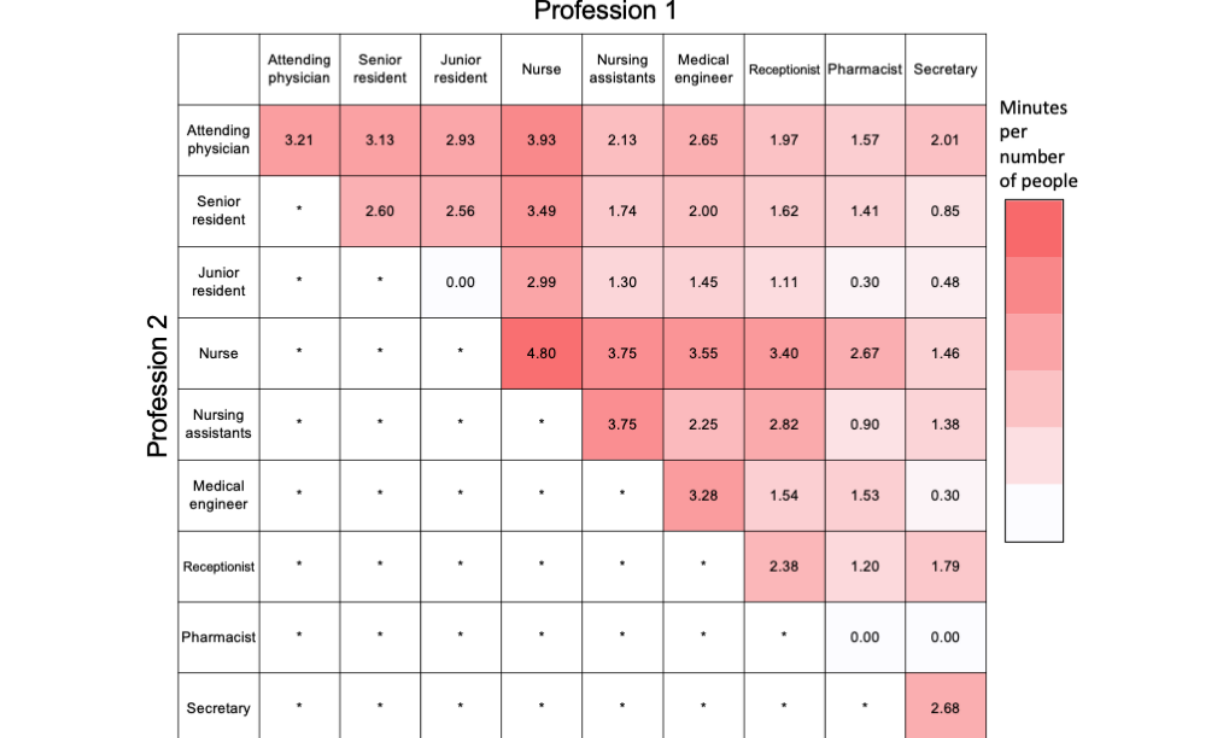
Figure 1. Pair preferences for active face-to-face interactions among the ICU staff. A heat map representation showing the cumulative lengths of the active face-to-face interactions (min x person) between specific pairs of professions. The data are displayed via a logarithmic scale that reflects the length of the interactions multiplied by the number of people. *Not